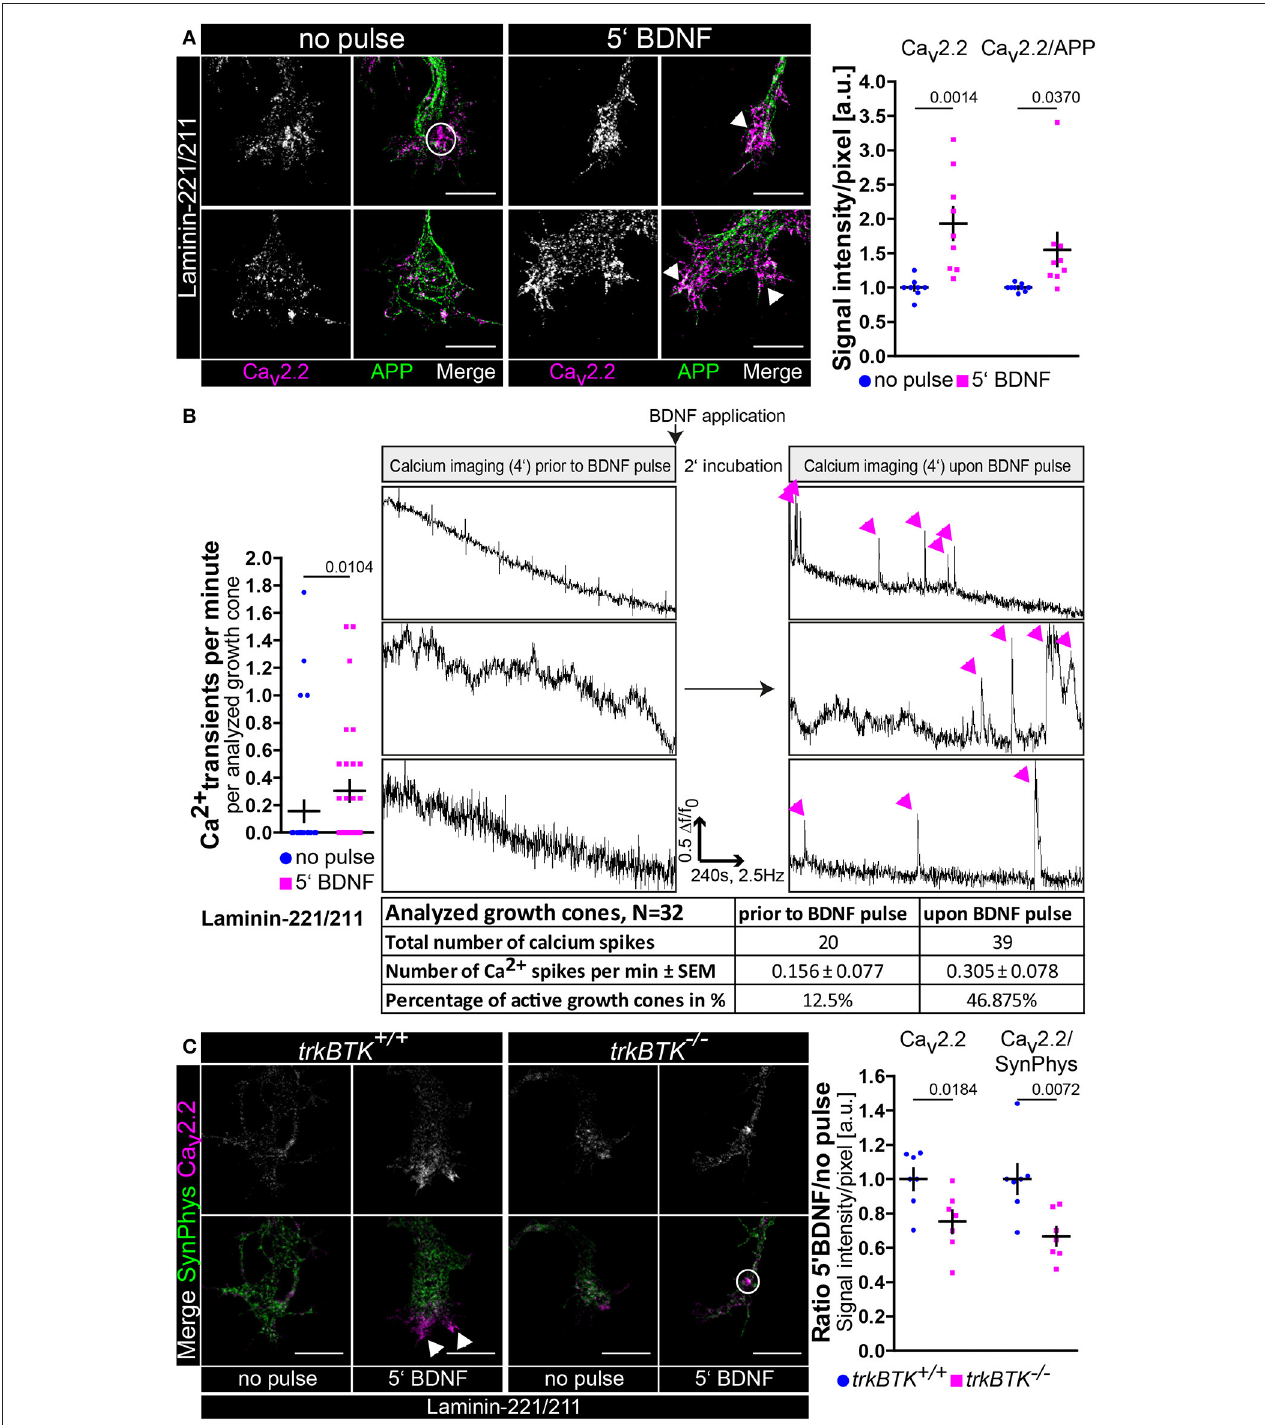
FIGURE 3 | BDNF signaling is sufficient to induce Ca v 2.2 clustering and local Ca 2 + transients at growth cone protrusions of embryonic motoneurons on laminin-221. (A) Representative images of axonal growth cones of non-pulsed and BDNF-pulsed axonal growth cones on laminin-221/211 stained against Ca v 2.2 (magenta) and APP (green) (scale bar: 5 µ m). Upon BDNF pulse Ca v 2.2 channels clustered at growth cone tips as highlighted by white arrowheads. In the non-pulsed condition potential accumulations of Ca v 2.2 channels were rather detected in central growth cone areas as indicated by white circles. Ca v 2.2 levels revealed a significant increase upon BDNF pulse (no pulse 1.00 ± 0.04, Q 2 1.00, n = 9, N = 221; 5 ′ BDNF 1.93 ± 0.24, Q 2 1.75, n = 9, N = 245; p = 0.0014). The ratio of